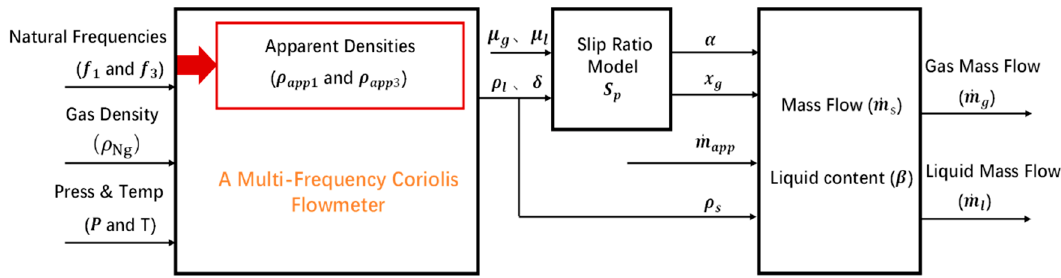
Figure 6. The block diagram of the compensation method with stratified flow based on the multi-frequency Coriolis principle.